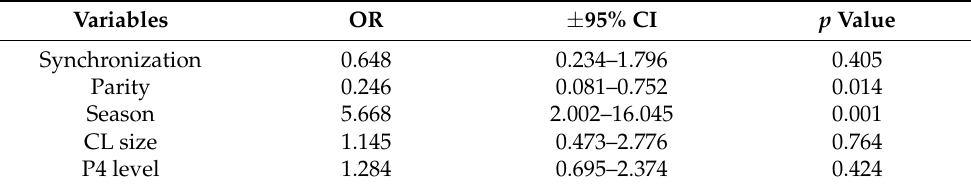
Table 4. Multiple logistic regression analysis of embryo transfer variables with respect to pregnancy rate.